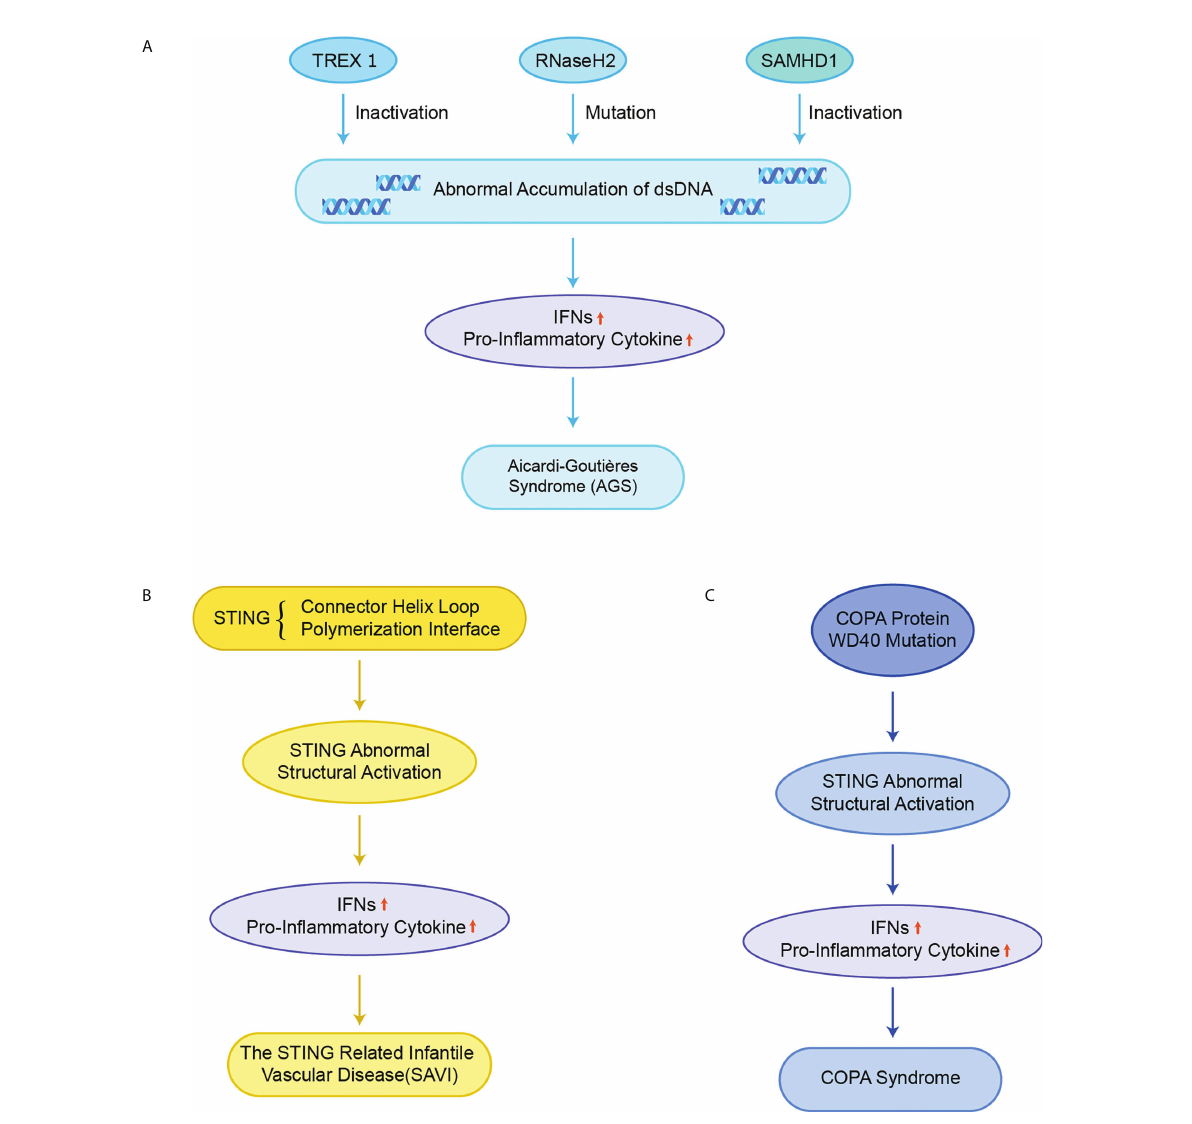
FIGURE 5 STING in monogenic autoin fl ammatory syndromes (A) Inactivation of TREX1, RNaseH2 and SAMHD1 leads to abnormal accumulation of dsDNA in normal cells, which over-activate the cGAS-STING signaling pathway, upregulates the expression of IFNs and pro-in fl ammatory cytokines, and ultimately triggers AGS; (B) Mutations in STING in the connector helix loop (N154S, V155M, and V147L) and the polymerization interface (G207E, R281Q, R284G, and R284S) lead to structural activation of STING, upregulating the expression of IFNs and pro-in fl ammatory cytokines, and ultimately causing SAVI; (C) Missense mutations in the structural domain of COPA WD40 impair endoplasmic reticulum binding and target protein sequencing, leading to structural activation of STING, upregulating the expression of IFNs and pro-in fl ammatory cytokines, and ultimately causing COPA